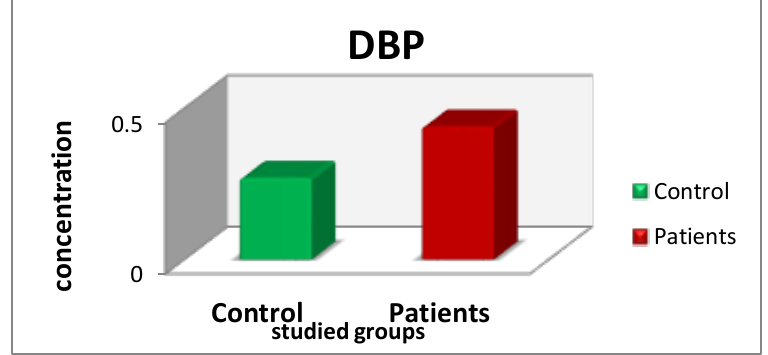
Figure 3: Levels of fasting blood sugar in patients and control group.